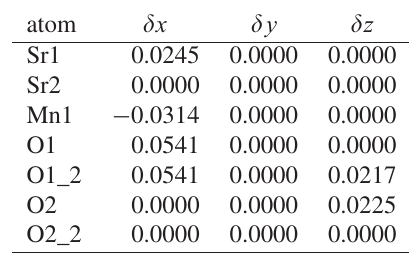
Table 10. Normalized polarization vector of the GM5 − distortion present in the C 222 1 structure of SrMnO 3 . Displacements are in relative units (normalization to 1Å of all displacements within a reference primitive unit cell). This corresponds to a 6-dimensional vector with components (0.1893, − 0.3429, 0.5119, 0.3946, − 0.5119, − 0.4085) in the basis of the 6 modes indicated in Table 9. Note the exact opposite values of the components corresponding to modes 3 and 5, which make null the y displacement of